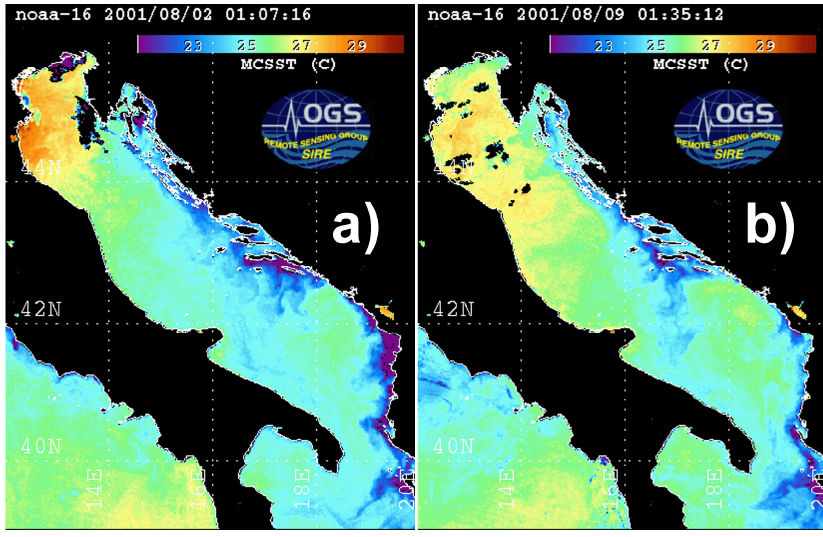
Fig. 4. (a) Sea Surface Temperature (SST) satellite image of the Adriatic at 01:07 UTC on 2 August 2001. (b) The same as in (a) except for 01:35 UTC on 9 August 2001. Courtesy of the OGS Remote Sensing Group.